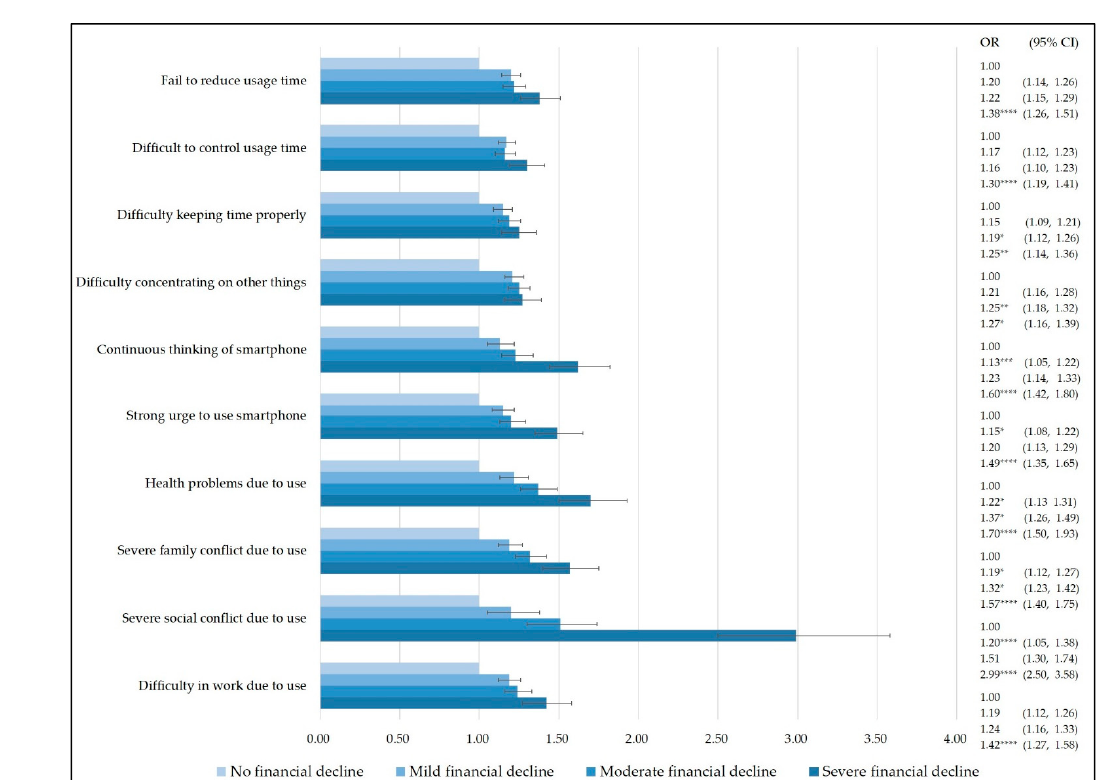
Figure 2. Results of subgroup analysis stratified by smartphone dependency questions (The risk of each item on the smartphone dependency scale was analyzed according to the severity of household